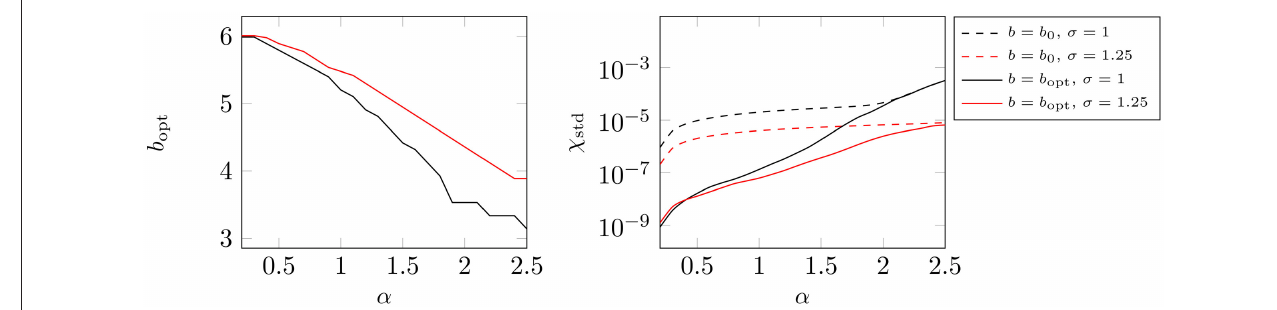
FIGURE 5 | Optimal shape parameters b opt (left) for the setting m measured errors χ std , which were obtained with b